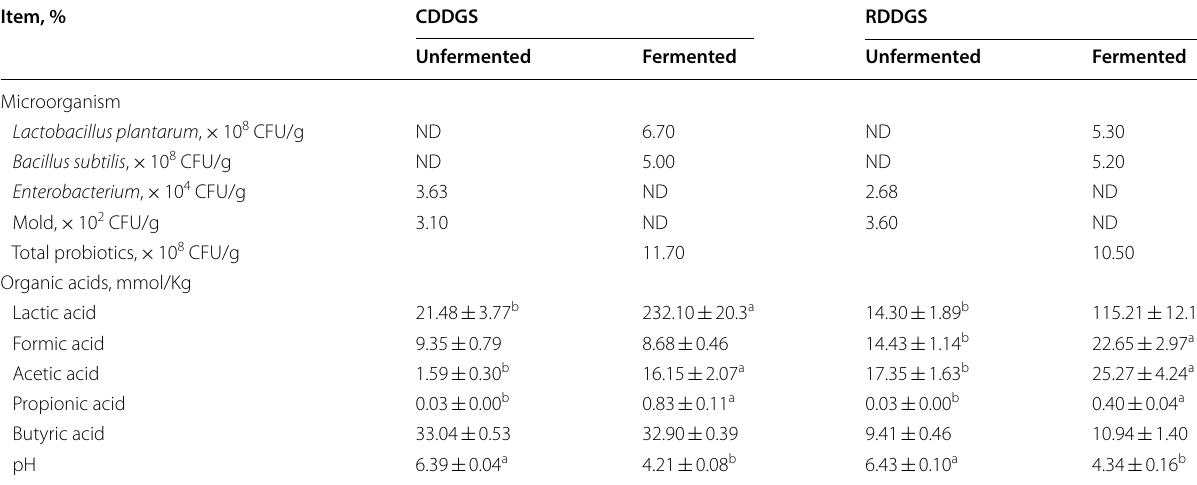
Values are means of three replicates per treatment. Means in a row without common superscript differ significantly ( P < 0.05)